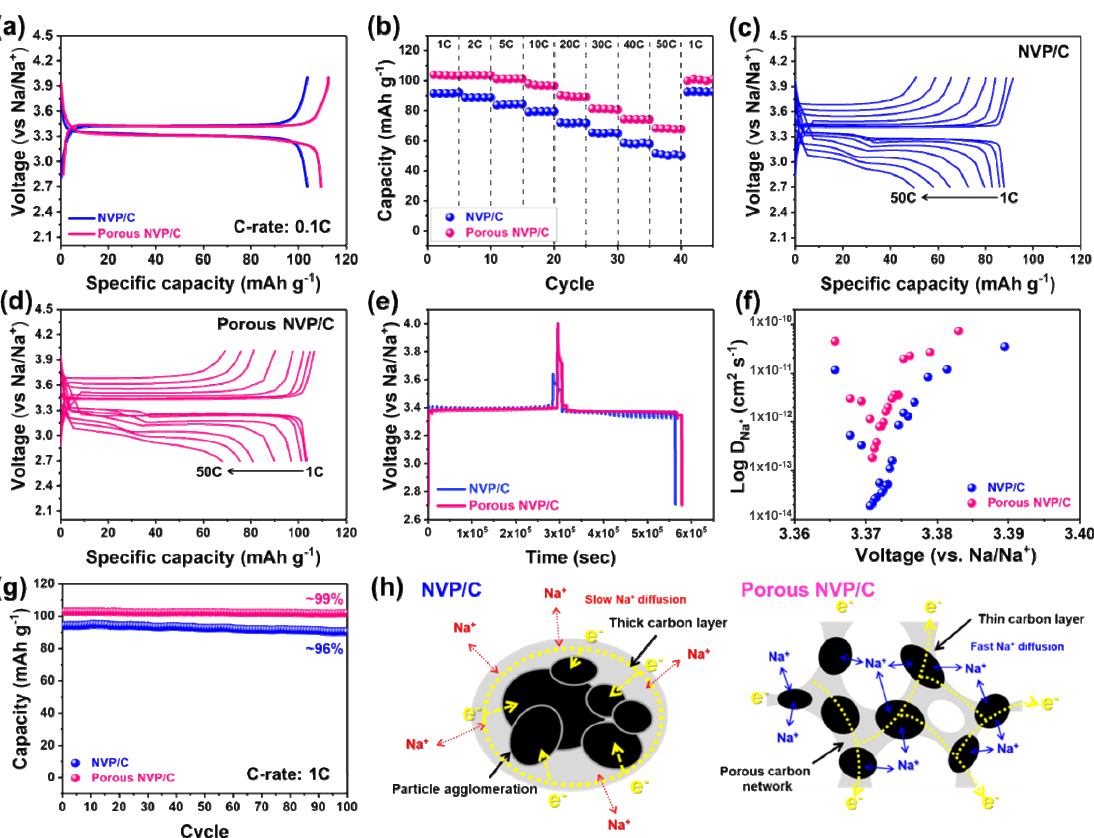
Figure 4. Electrochemical performances validation of the NVP/C and Porous NVP/C composites. ( a ) Galvanostatic charge–discharge curves measured at 0.1 C in a voltage window of 2.7–4.2V. ( b ) Rate capability measured from 1 to 50 C. ( c ) Voltage profile of the NVP/C composites at a specific capacity range of 0–120 mAh g − 1 . ( d ) Voltage profile of the Porous NVP/C composites at a specific capacity range of 0–120 mAh g − 1 . ( e ) Galvanostatic intermittent titration technique (GITT) curves measured using the current flux at 0.05 C for 20 min for the relaxation time of 2 h. ( f ) Sodium ion diffusion coefficient during the discharge process of the NVP/C and Porous NVP/C composites calculated from the GITT results. ( g ) Cyclic performance at a rate of 1 C over 100 cycles. ( h ) Schematic illustration comparison between the NVP/C and Porous NVP/C composites for illustrating the beneficial sodium ion and electron transfer in the Porous composite structure toward the improved electrochemical properties.